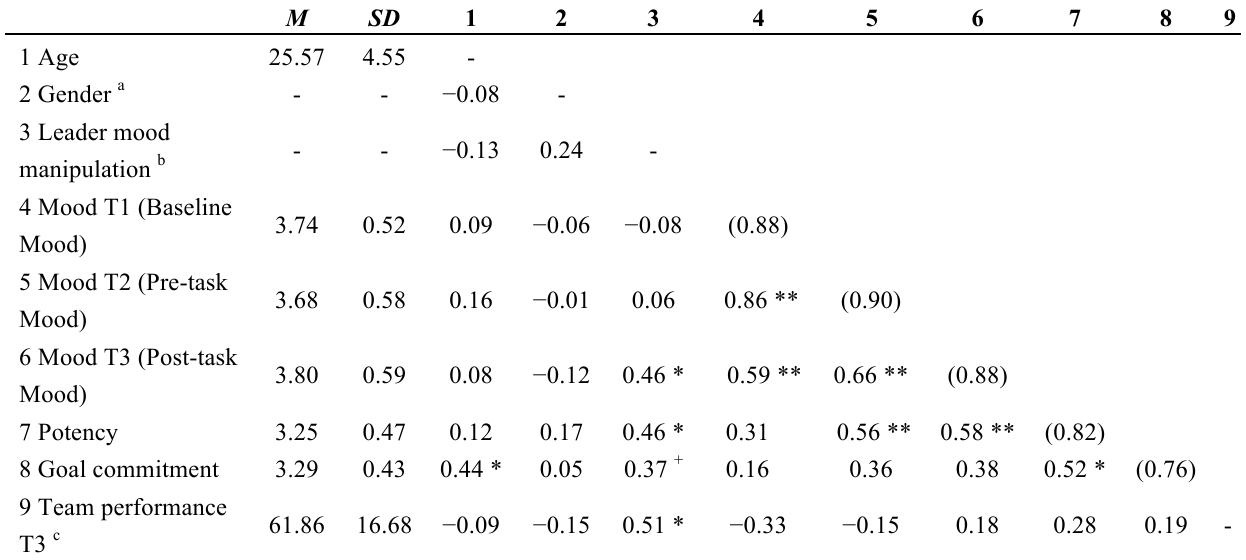
Table 1. Descriptive statistics and correlations between main study